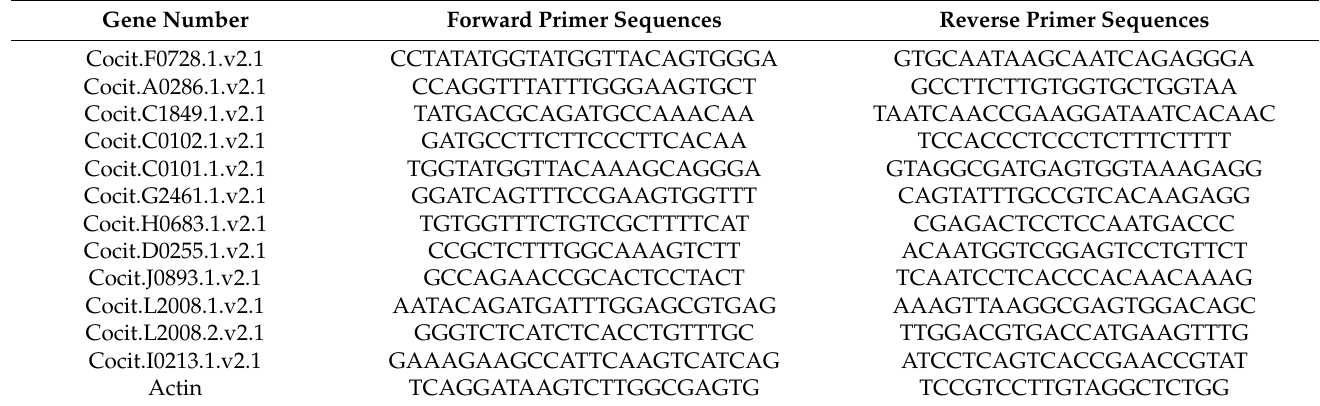
Table 1. Primer sequences of CcCesA gene family for qRT-PCR.